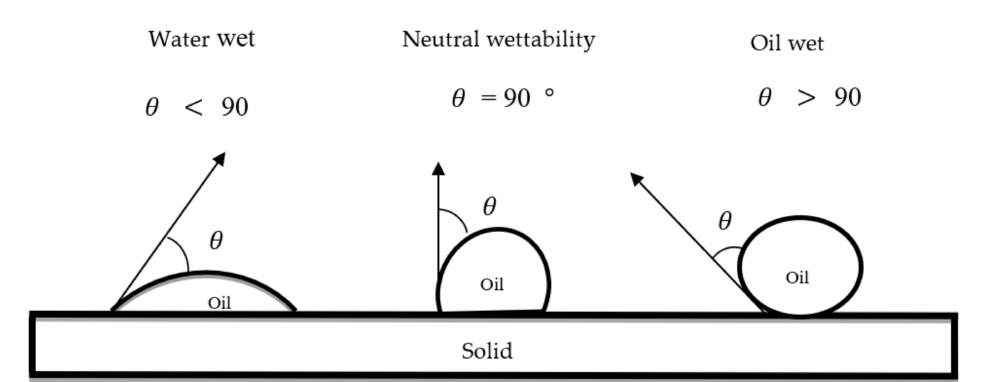
Figure 2. Wettability of rock surface.